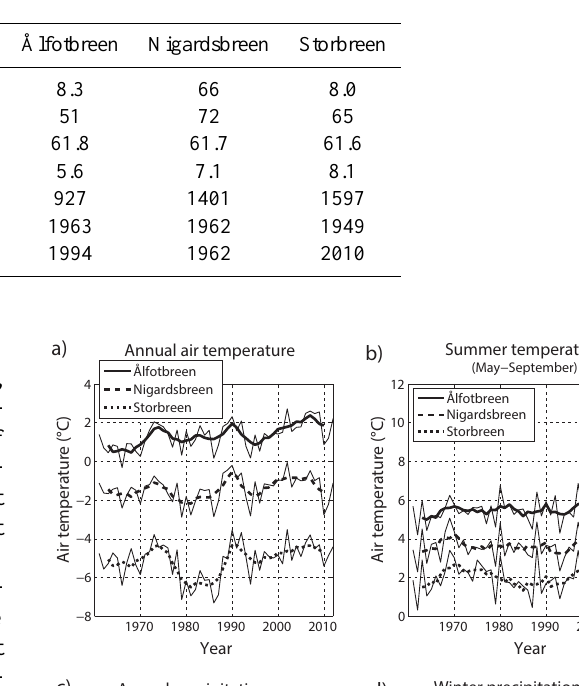
Table 1. Overview of the three study catchments.